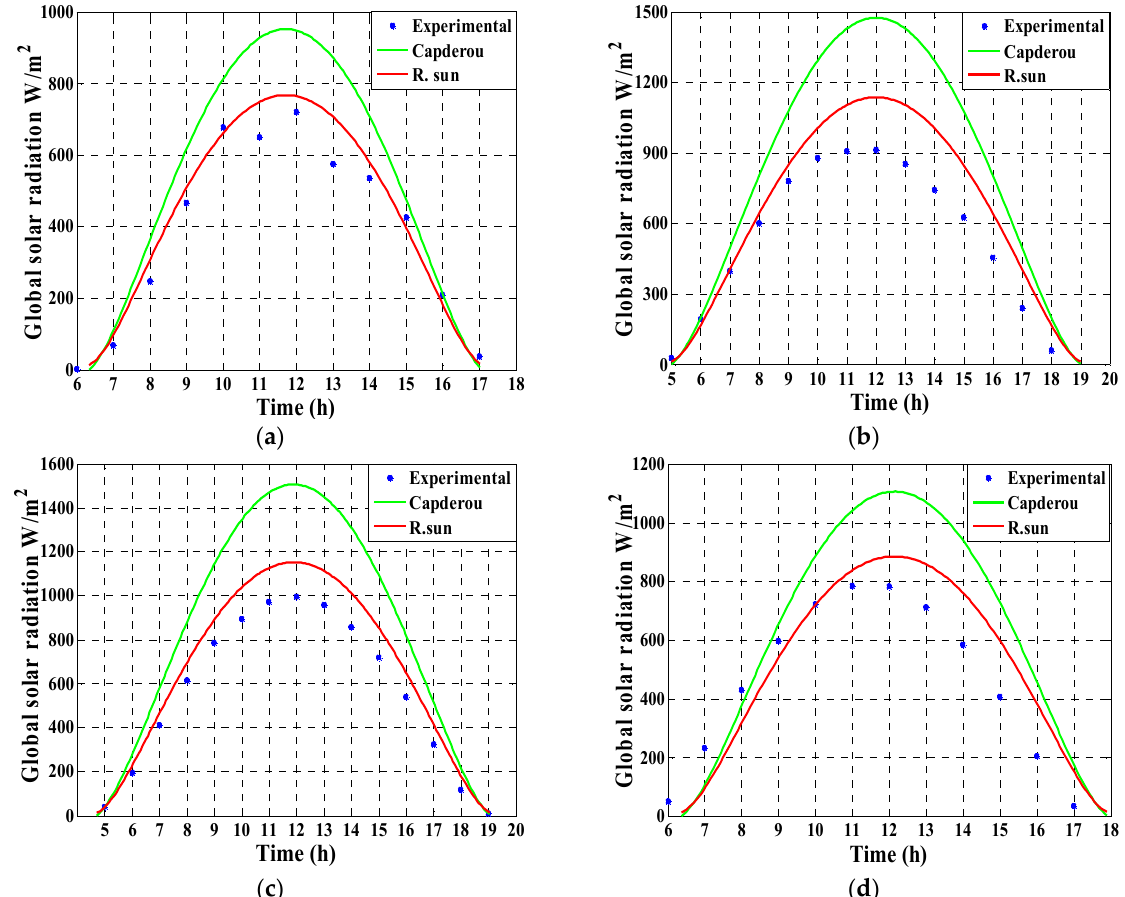
Figure 8. The comparison between the measured global solar radiations and the global solar radiation obtained by Capderou and R.Sun models for the site of Senia. ( a )16 February 2006; ( b ) 20 May 2006; ( c ) 1 July 2006; ( d ) 2 October 2006. Diffuse Solar Radiations Figure 9 presents the diffuse solar radiation estimated by the Capderou and R.Sun models, and the collected measurements on the site of Senia, where four days under clear skies are selected from different seasons to achieve this study.